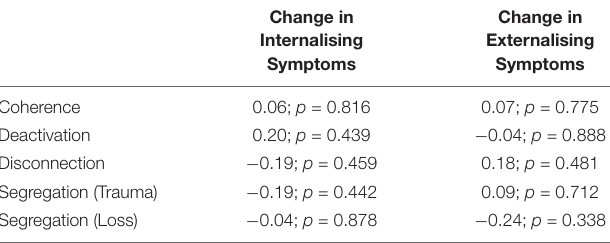
TABLE 5 | Spearman’s correlations (r s ) of defense processes [Coherence, Deactivation, Disconnection, Segregation (Trauma), and Segregation (Loss)] and the CBCL change scores (Internalising and